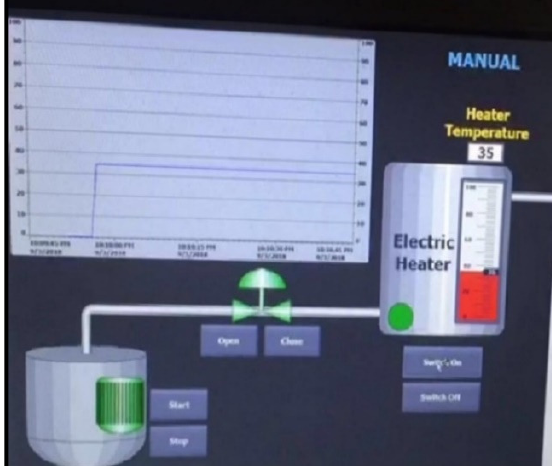
Fig. 8. Trend view for temperature sensor.